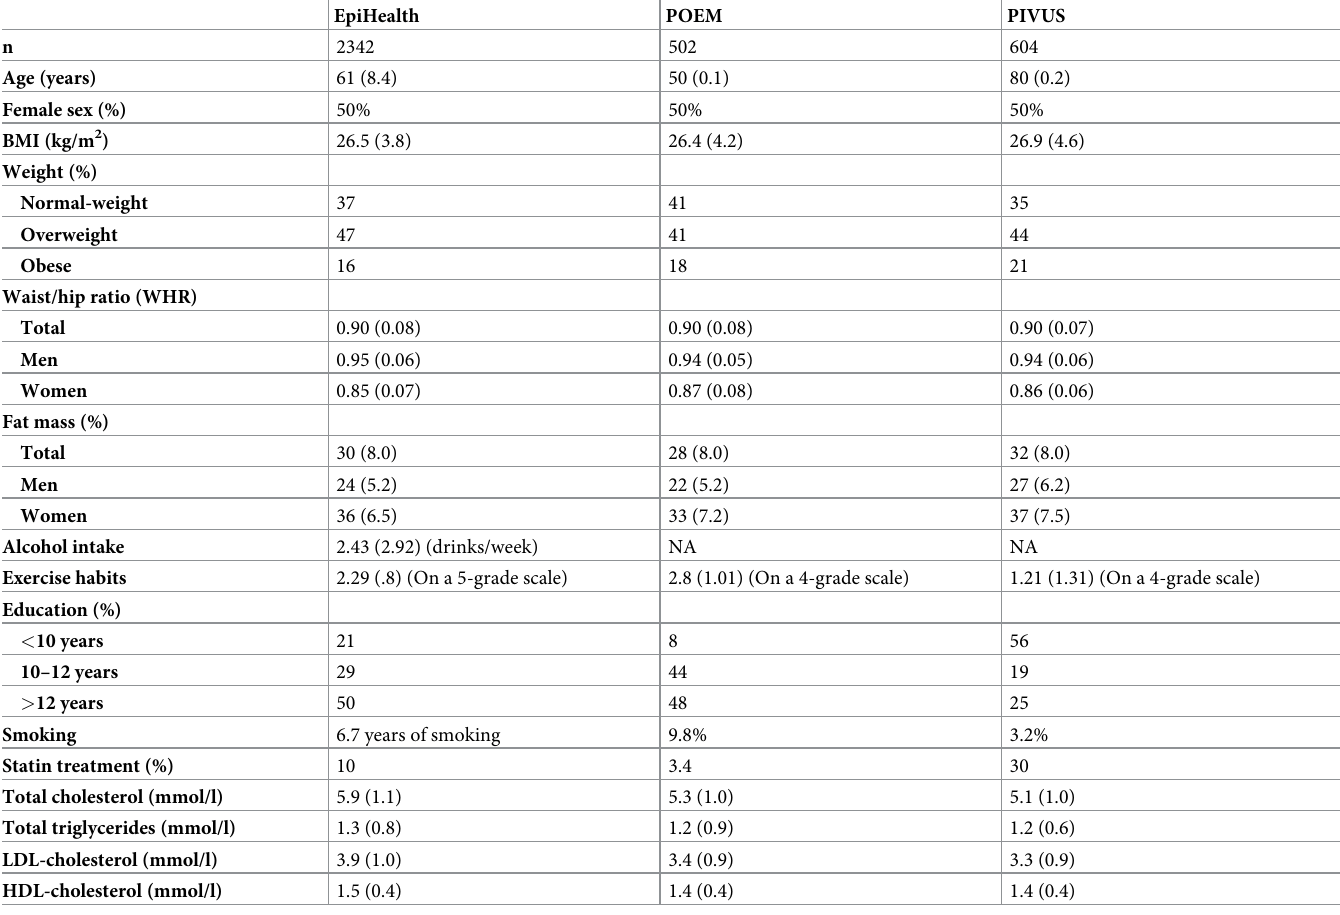
Table 1. Basic characteristics of the three samples. Means and standard deviations (in parenthesis) or proportions are